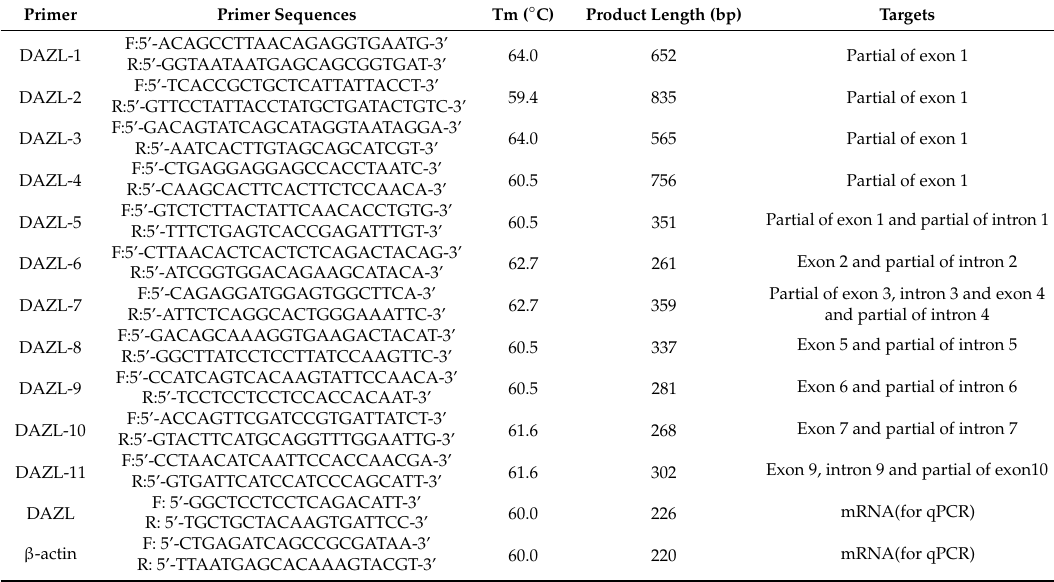
Table 1. PCR primer sequence information and annealing temperatures for deleted in azoospermia-like (DAZL)